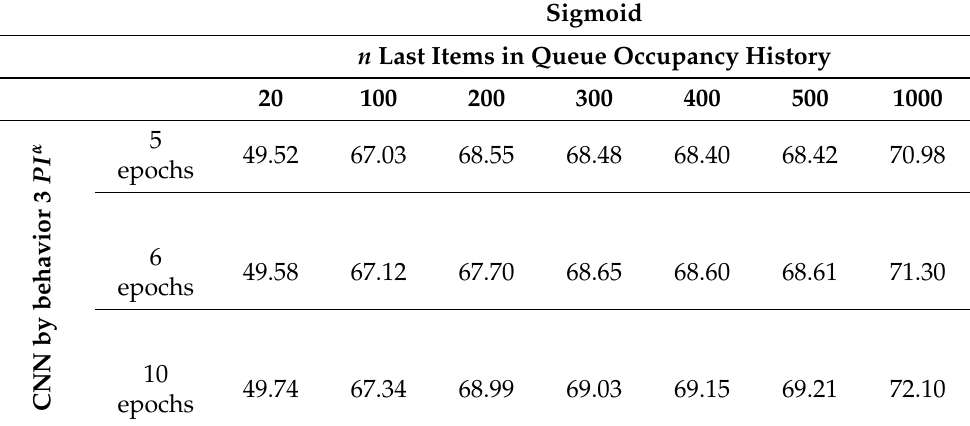
Table 5. The accuracy measurements for test data for a neural network model trained with data representing the behavior of three controllers simultaneously, given n recent queue occupancy history